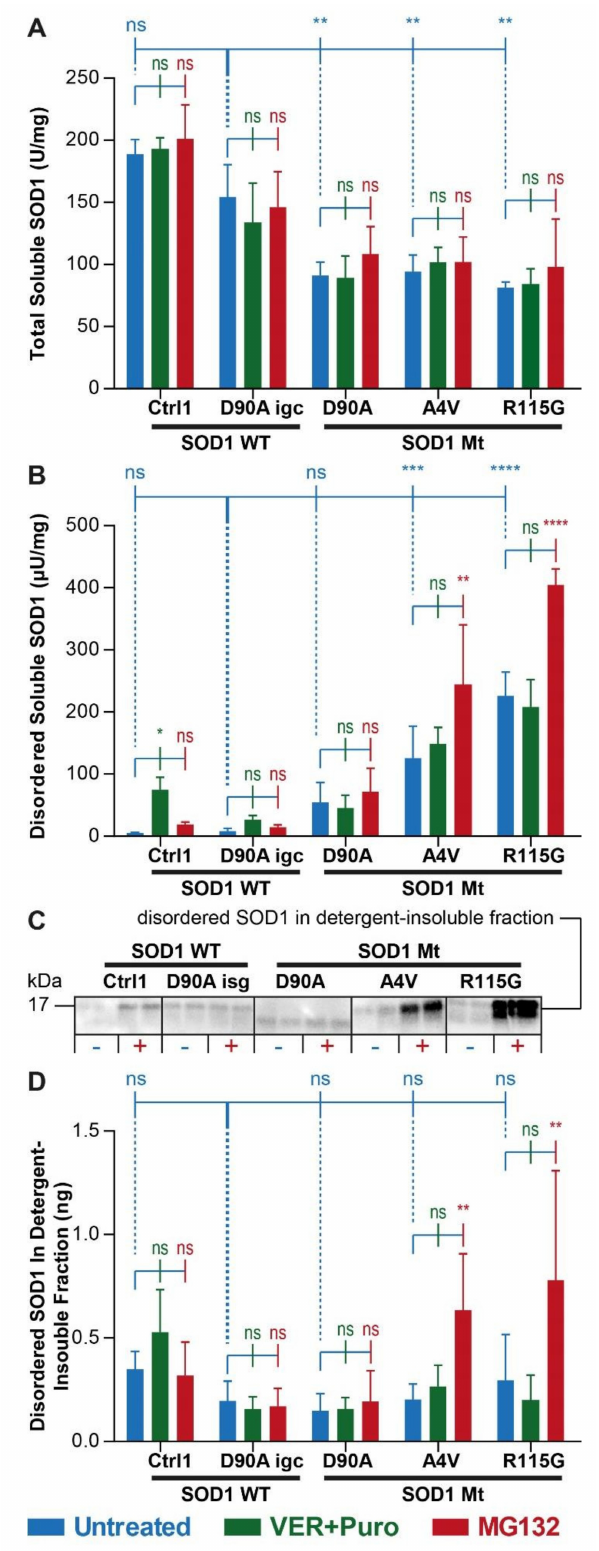
Figure 2. SOD1 misfolding is induced by proteome inhibition but not stress granule assembly in SOD1 mutant MNs. ( A ) Levels of total soluble SOD1 in supernatants of spinal MN extracts by ELISA performed with an antibody recognizing all natively folded and misfolded SOD1